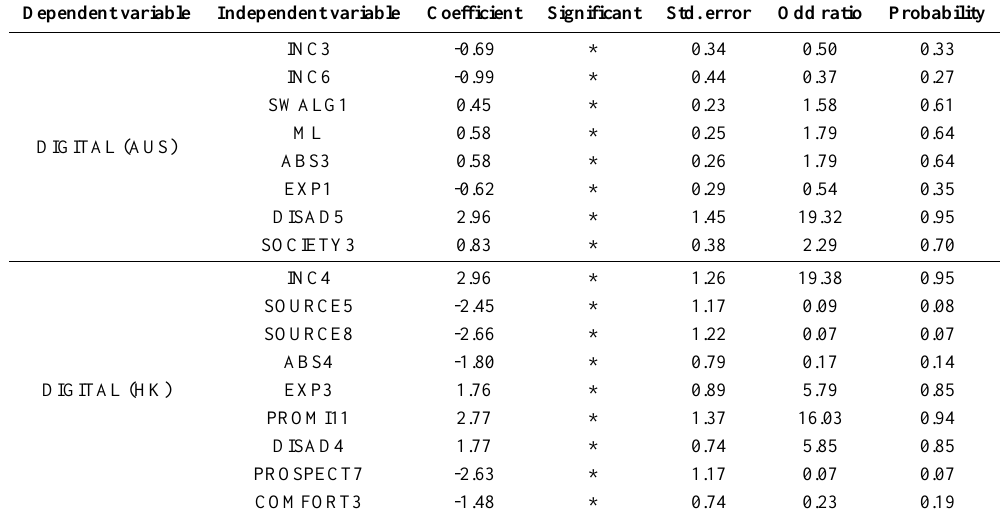
Table B-10. Lack of clarity on how digital divide and technology disruption on the disadvantaged communities will be addressed Dependent variable